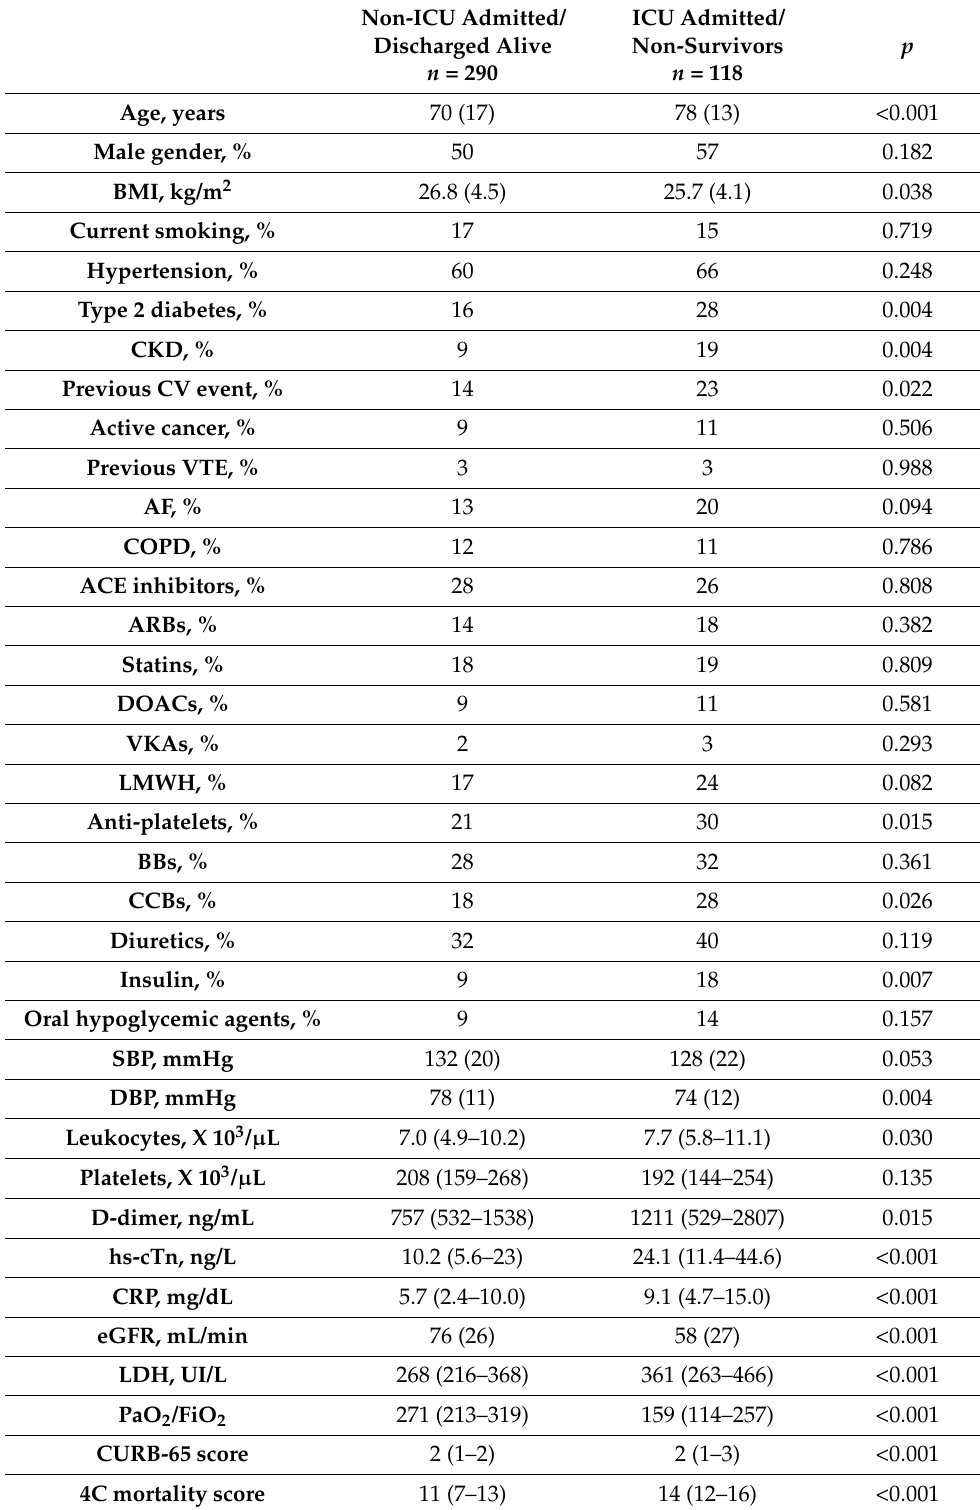
Table 3. Baseline characteristics of the study population according to the composite endpoint of ICU admission/in-hospital